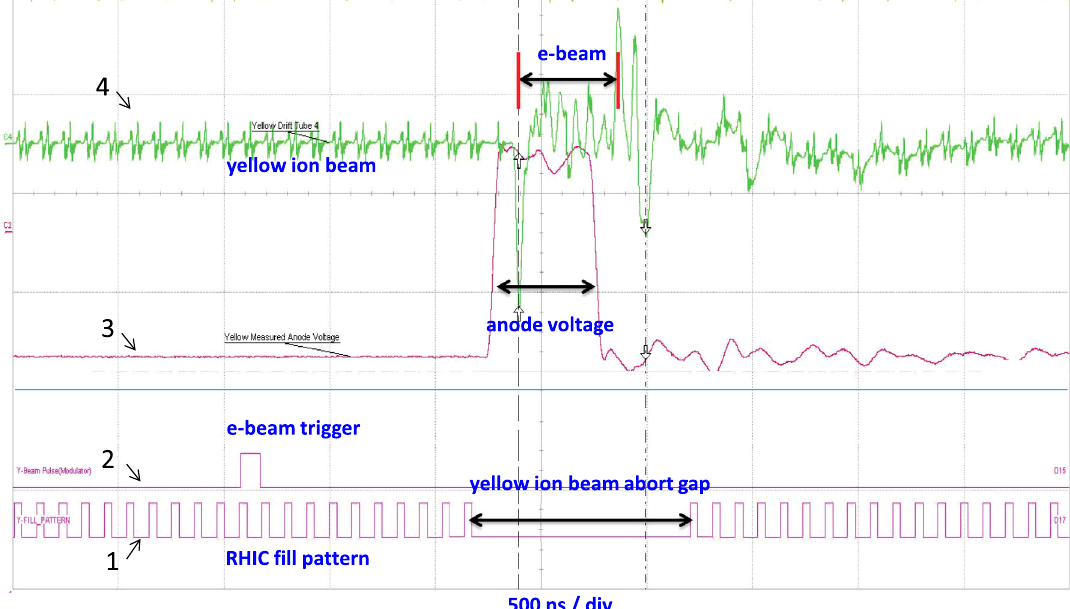
FIG. 14. Longitudinal alignment of the electron beam pulse within the ion beam abort gap.